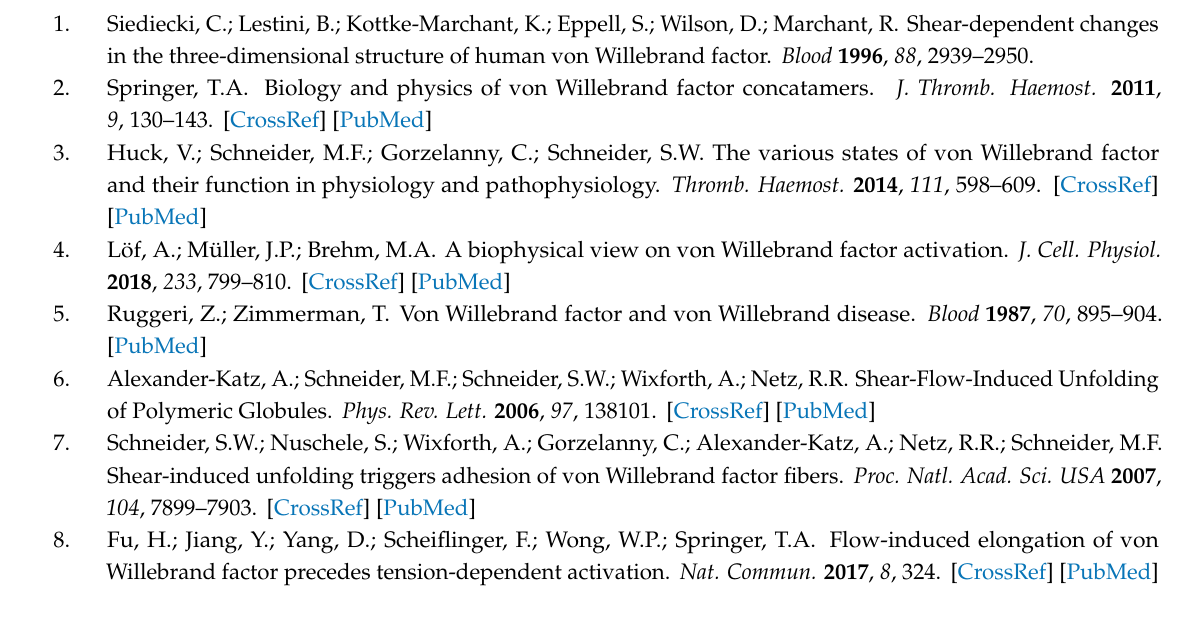
Figure S1: Grafted scenario: Comparison of different quantities which maximal value determines an estimate for the critical shear rate ˙ γ ∗ , indicated by vertical dashed lines. Blue indicates that the quantity uses R 2 R 2 , Figure S2: Non-grafted scenario: Comparison of different quantities which maximal value determines an S estimate for the critical shear rate ˙ γ ∗ , indicated by vertical dashed lines. Blue indicates that the quantity uses R 2 , red uses R 2 , Table S1: Explicit simulation parameters for (a) the grafted and (b) the non-grafted scenario G S used in this study, Table S2: Grafted scenario: Comparison of the critical shear rate estimates in units of τ − 1 , determined as depicted in Figure 1 as the maximum value of the specific shear-rate dependent quantity, for different monomer numbers, Table S3: Non-grafted scenario: Comparison of the critical shear rate estimates in units of τ − 1 , determined as depicted in Figure S2 as the maximum value of the specific shear-rate dependent quantity, for different monomer